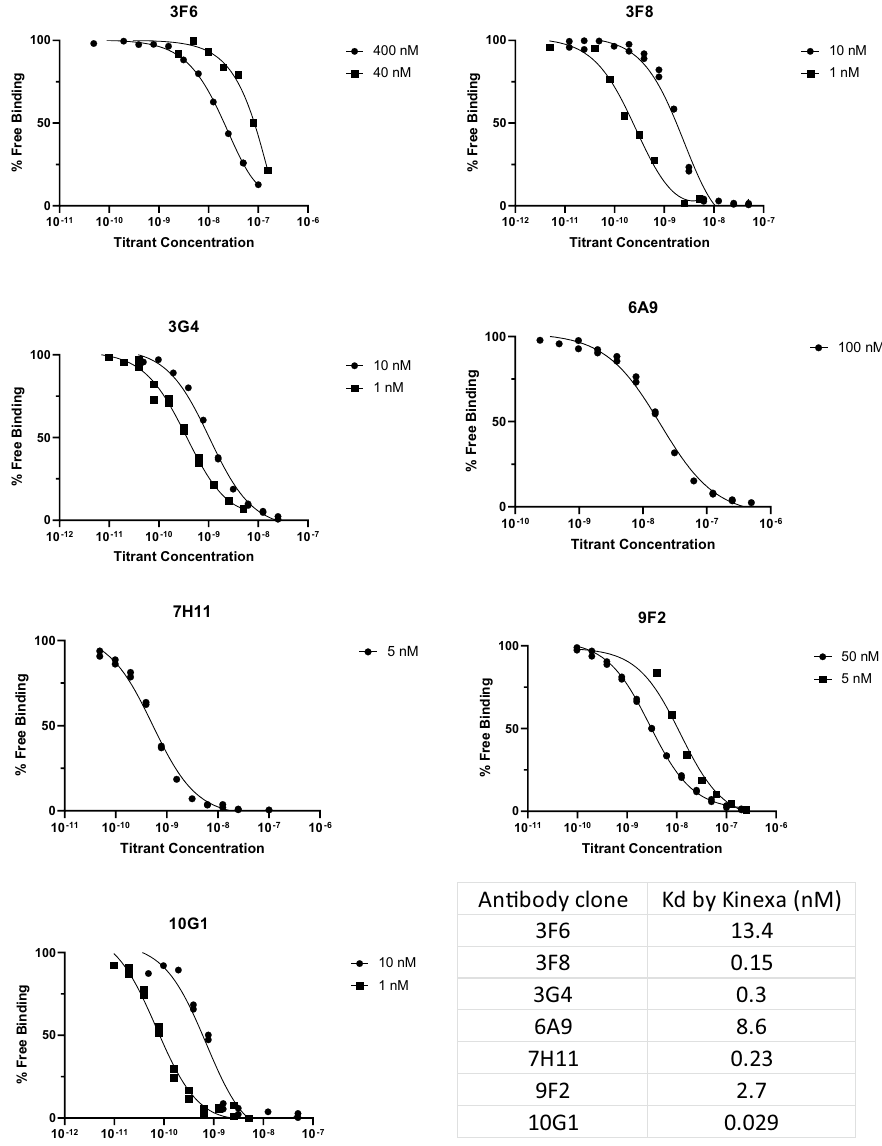
Figure 2 . KineXa determined binding affinities of anti-RON antibodies on mammalian expressed extracellular RON